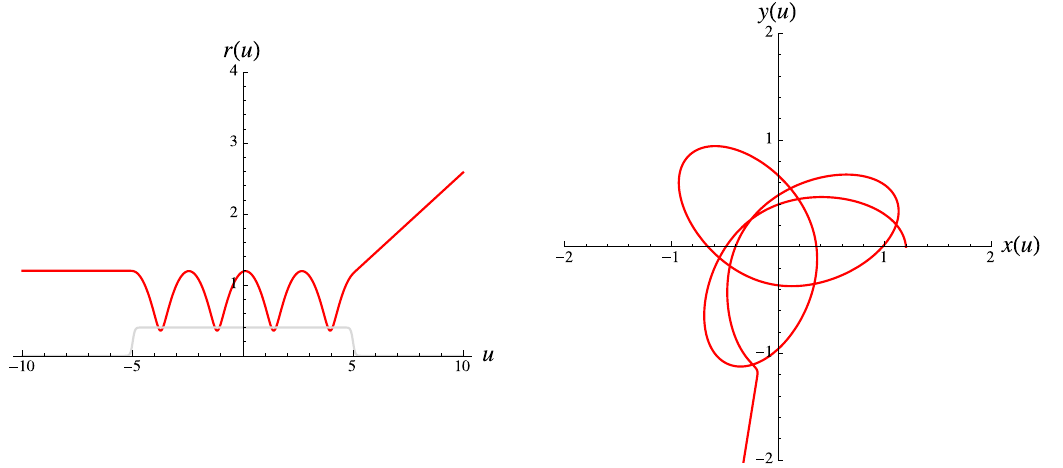
Figure 8 . The left-hand plot shows the behaviour of r ( u ) through the encounter with a gyraton with pro(cid:12)le (cid:31) F ( u ) = (cid:31) J ( u ) = (cid:2)( u; L ), shown here with L = 10. The right-hand plot shows the test particle following a precessing orbit around the gyraton axis before emerging as a straight line in the memory region after the passage of the gyraton.